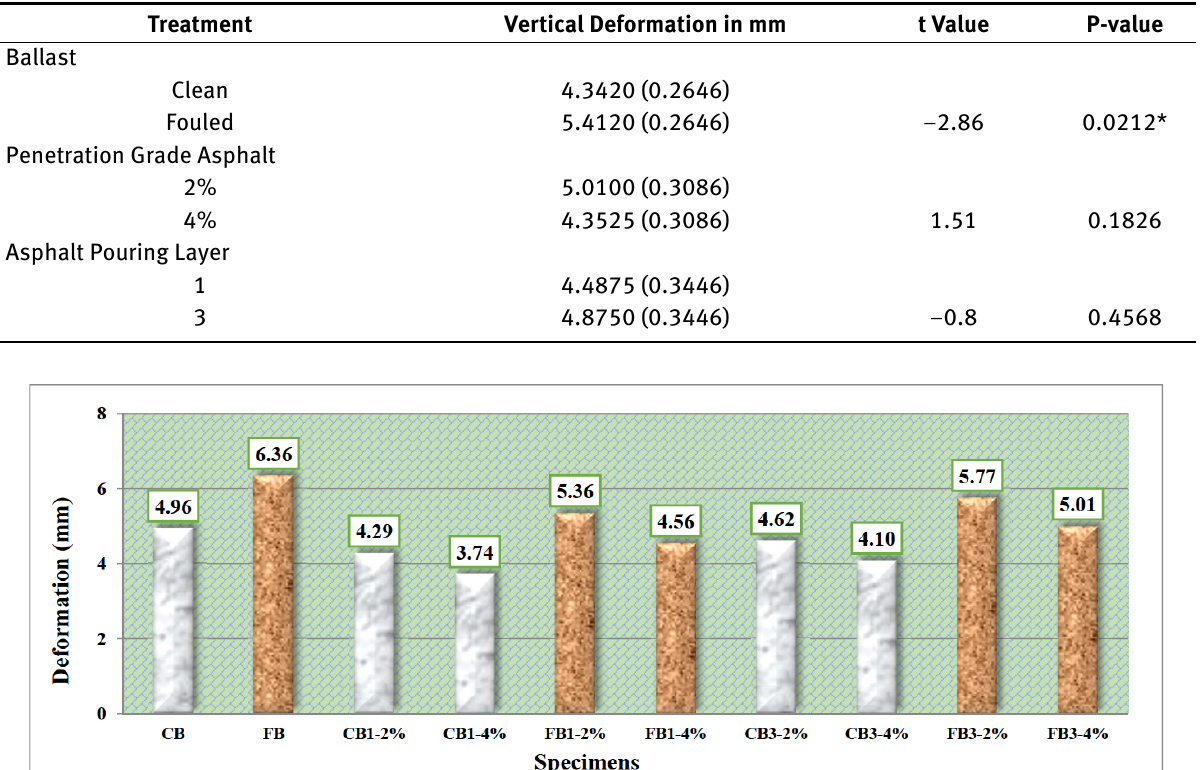
Lastly, same ballast condition (clean or fouled) and same asphalt content (2% or 4%) will produce similar specimen weight regardless of how many layers were poured with as-